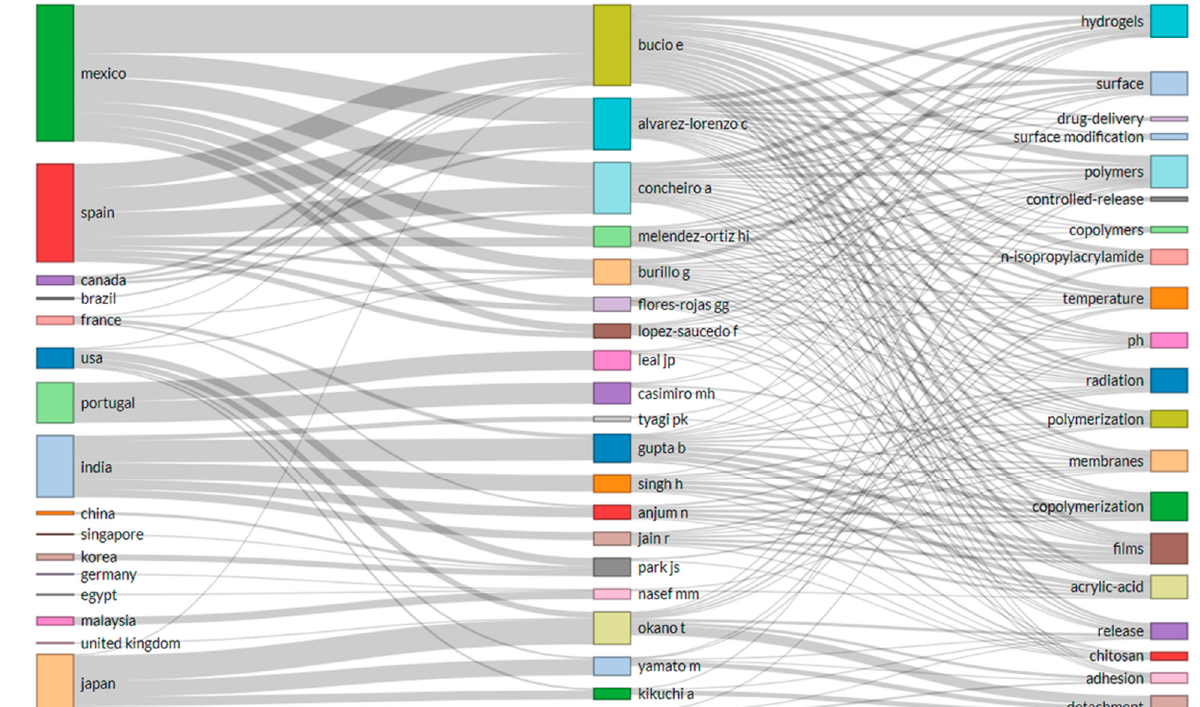
Figure 8. Three-factor plots of the relationship among countries–authors keywords (keywords cloud generated from titles and abstracts) for FPBMs prepared by RIGC literatures. Obtained from that was obtained using Biblioshiny (R-Studio) software.